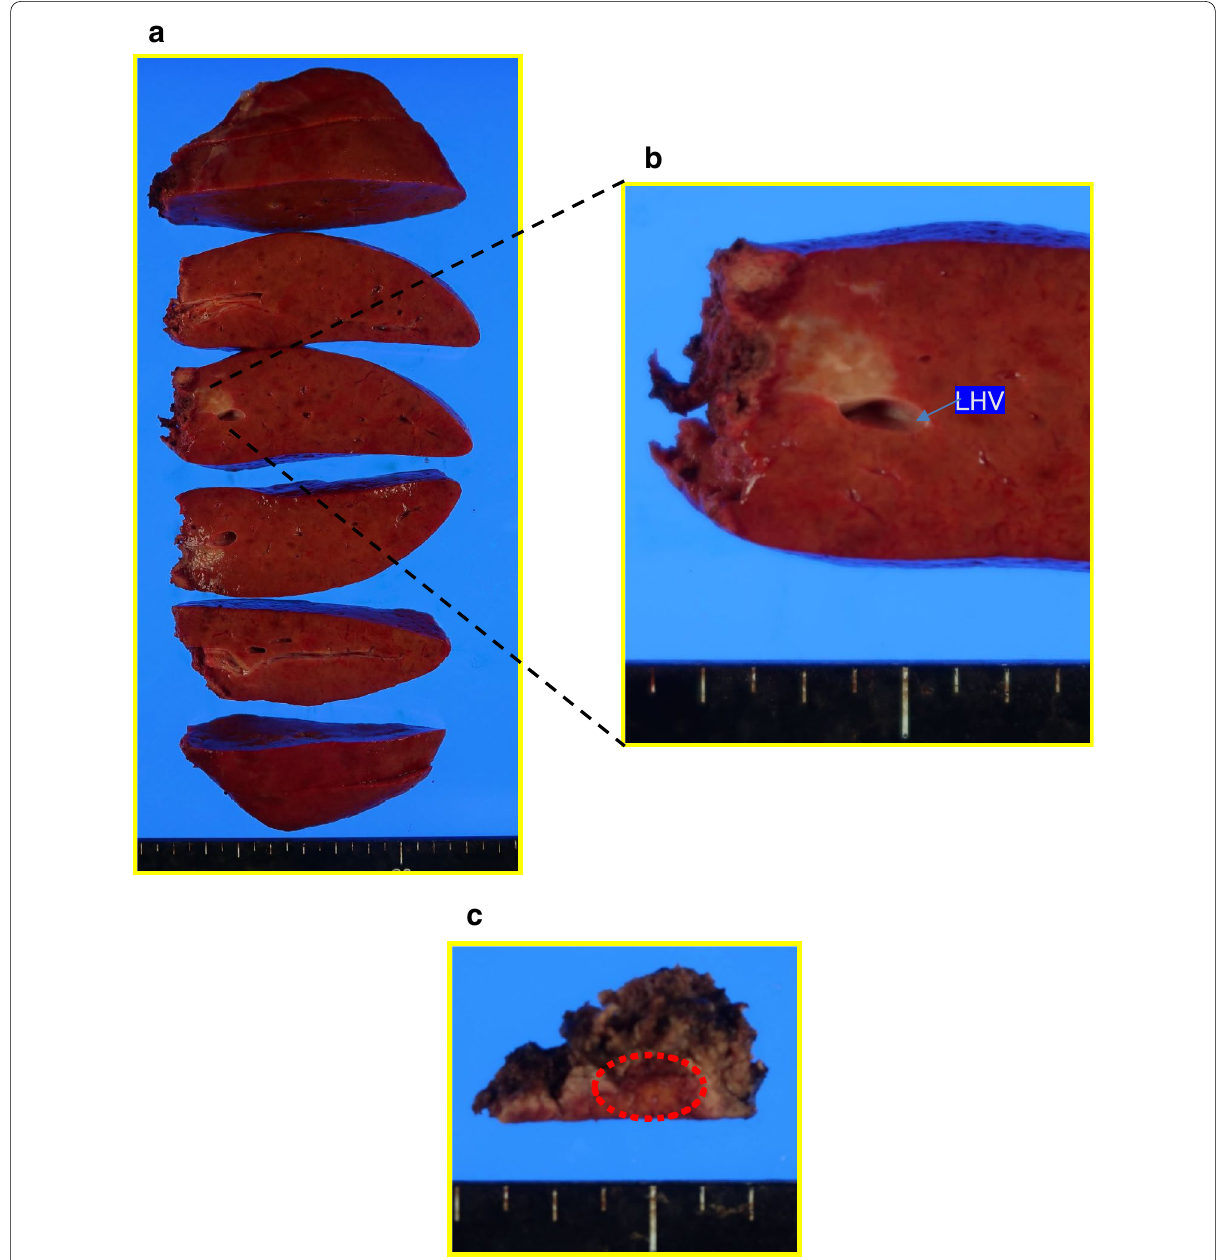
Fig. 3 Gross appearance of the lesions removed via laparoscopic hepatectomy. a White nodules in segment III. b As indicated by the preoperative imaging studies, the tumor was in contact with the left hepatic vein. c A white nodule was also found in segment VIII